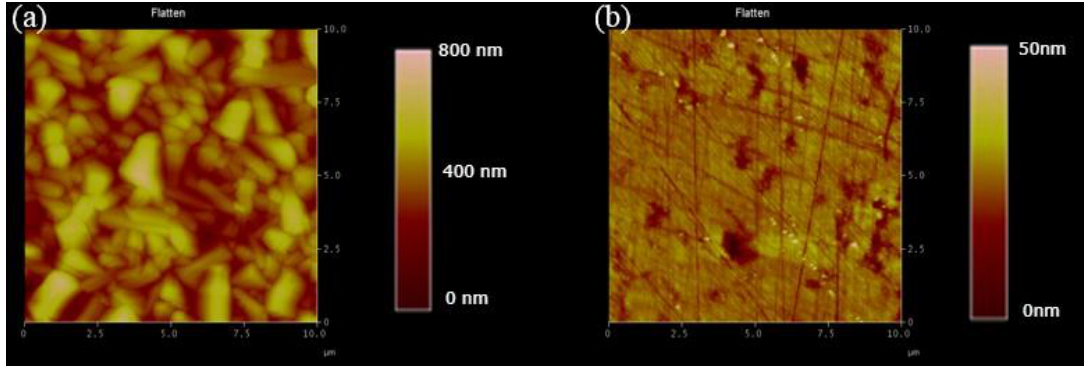
Figure 4. ( a , b ) AFM measurements of the Cu 2 O film before and after polishing.